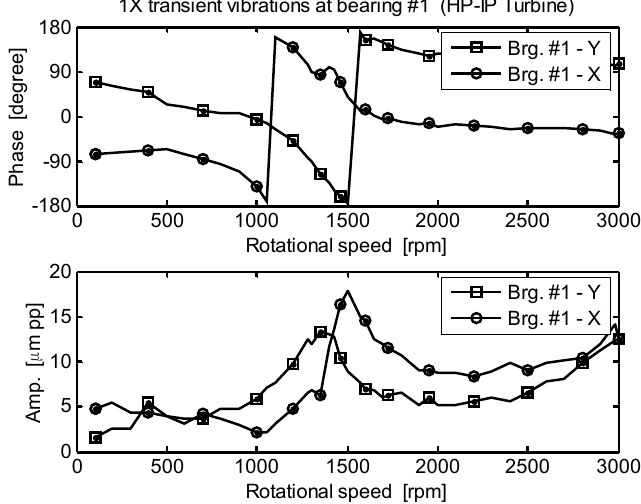
Fig. 4. Bode plot of the 1X transient vibrations measured at bearing #1 during a reference runup.